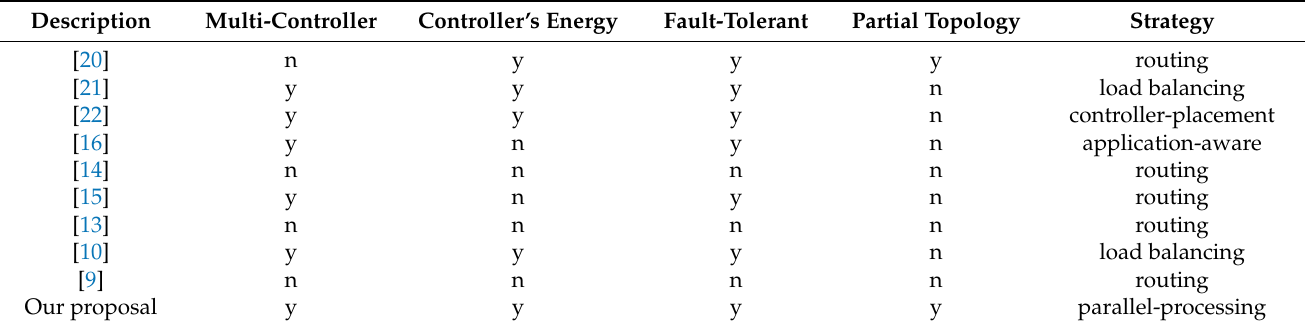
Table 1. SDN energy-efficiency related